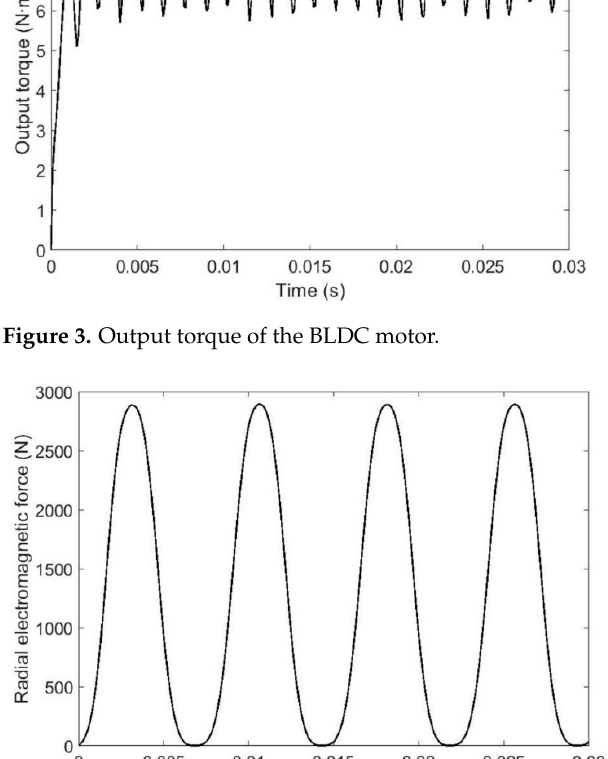
Figure 4. Radial EM force acting on a single stator tooth.